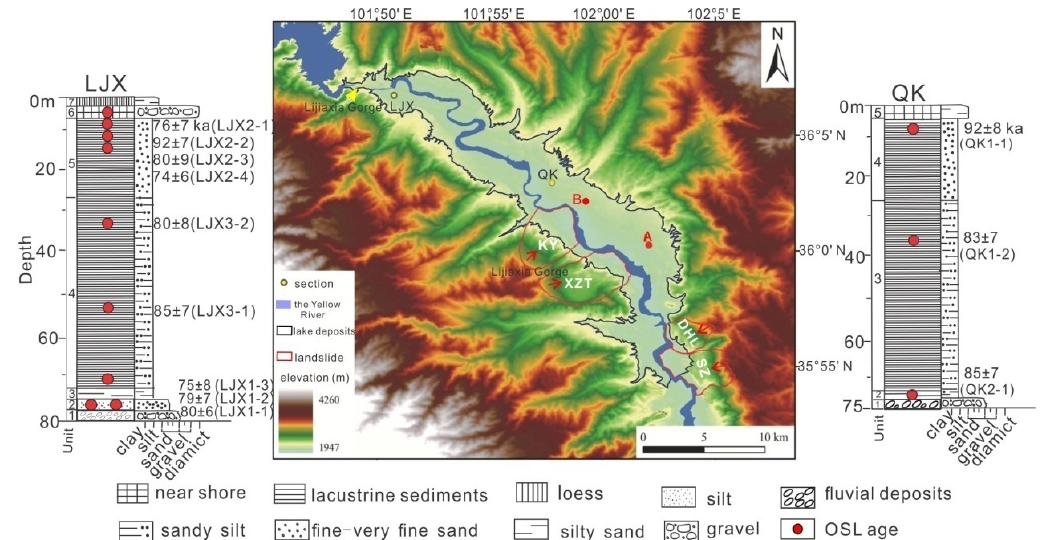
Figure 3. Digital elevation model (DEM) view for the reconstructed lake extent that is represented by the dark lines and current bed of the Yellow River is represented by blue lines. Dehenglong, Suozi, Xiazangtan and Kangyang landslides, Qunke and Lijiaxia lacustrine sediment sites are abbreviated as DHL, SZ, XZT, KY, QK, and LJX. “A” in the map denotes the outcrop where the nearshore of the dammed lake overlaid Xiazangtan landslide mass on the west bank of Xiazangtan landslide, see Figure 5A for details. “B” in the map denotes that lacustrine sediments at the front lobe of Kangyang landslide were also deformed into a series of asymmetric folds with 2–3 m amplitude, see Figure 5B for details.